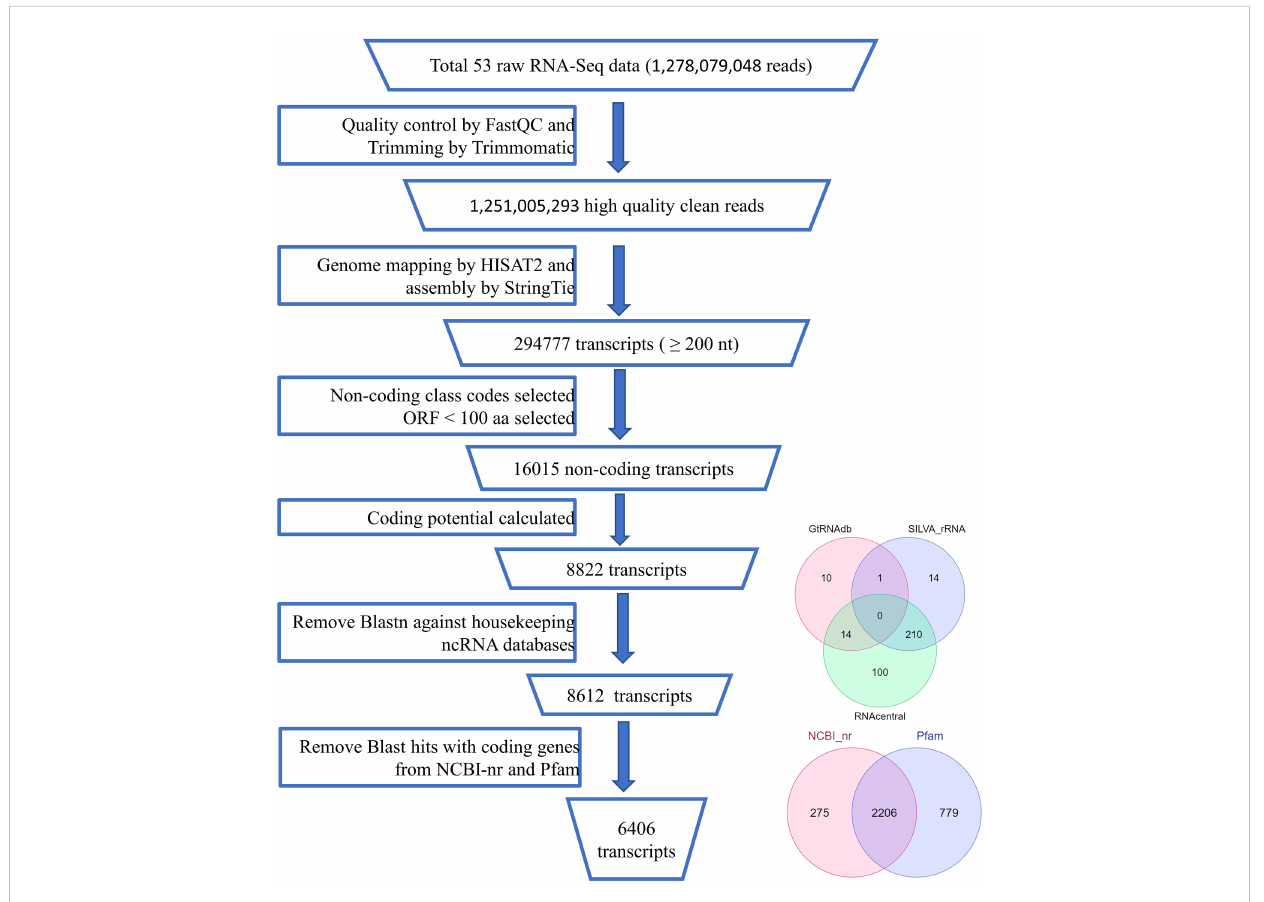
FIGURE 1 Pipeline of lncRNA identi fi